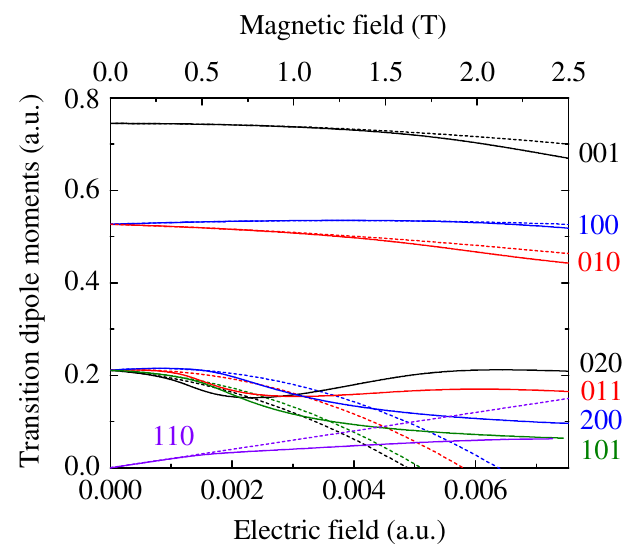
FIG. 3. (Color) Transition dipole moments from the ground state to different parabolic states as a function of electric field in the particle rest frame. The dashed lines represent the moments calculated using second order perturbation theory [18]. The upper scale presents the dependence on transverse magnetic field in the laboratory frame for a 4 GeV